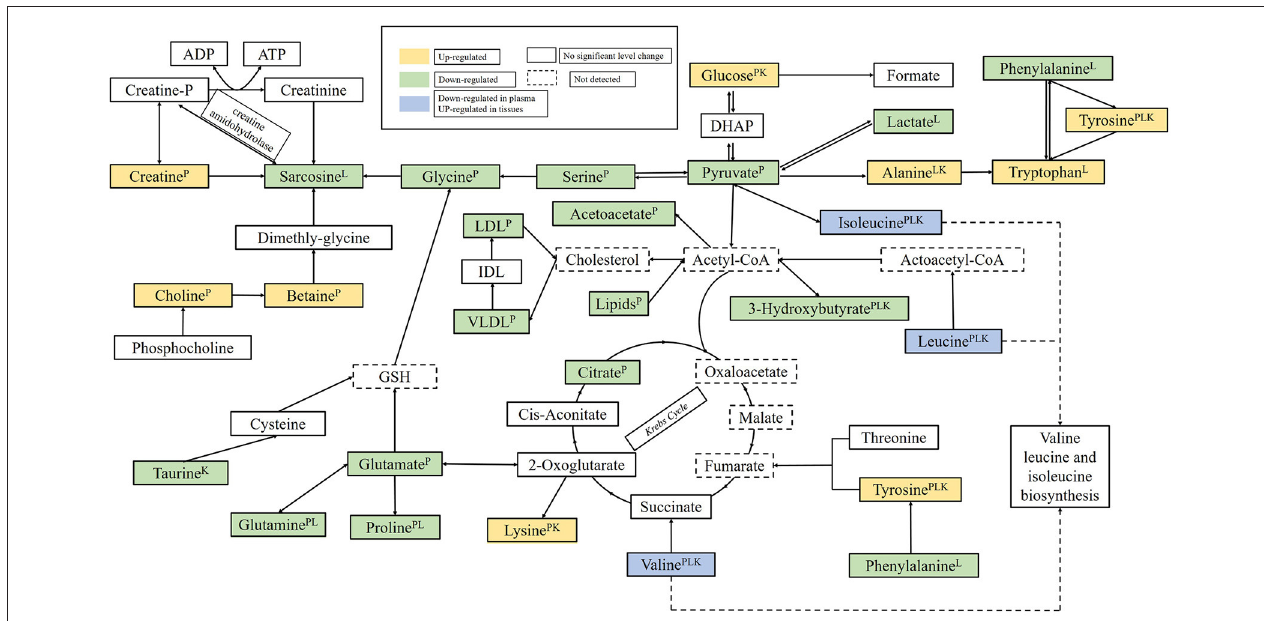
FIGURE 9 | The perturbed metabolic pathways detected by NMR analysis, showing the interrelationship of the identified metabolic pathways. Metabolites with superscript “P” means that levels of metabolites from plasma were changed significantly; “L” means that levels of metabolites from liver tissue were changed significantly; “K” means that levels of metabolites from kidney tissue were changed